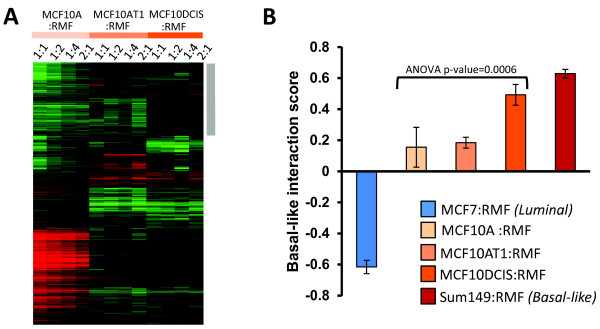
MCF10A series progressively acquires basal-like microenvironment characteristics. (A) One-dimensional (genes only) hierarchical clustering showing interaction scores (I values) for genes that significantly change due to coculture. Distinct clusters of genes are upregulated in each cell line. A gray bar adjacent to the heat map shows a cluster of genes that are uniquely upregulated in the MCF10DCIS:RMF cocultures. (B) A basal-like interaction score was developed previously by Camp and colleagues [5]; the coculture data show a strong relationship between progression and expression of basal-like microenvironment characteristics. Luminal cocultures had a negative basal-like interaction score, while the score increased with progression from A/AT1 to ductal carcinoma in situ (DCIS), with DCIS having interaction scores similar to those in the basal-like invasive cancer cell line SUM149. ANOVA, analysis of variance; RMF, reduction mammoplasty fibroblast.